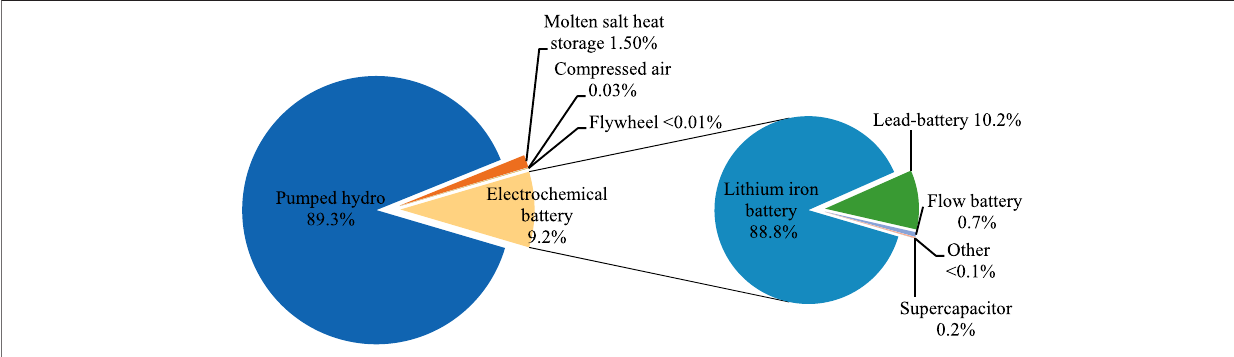
FIGURE 5 | Installed structure distribution of energy storage projects for China in 2020 (source: CNESA).